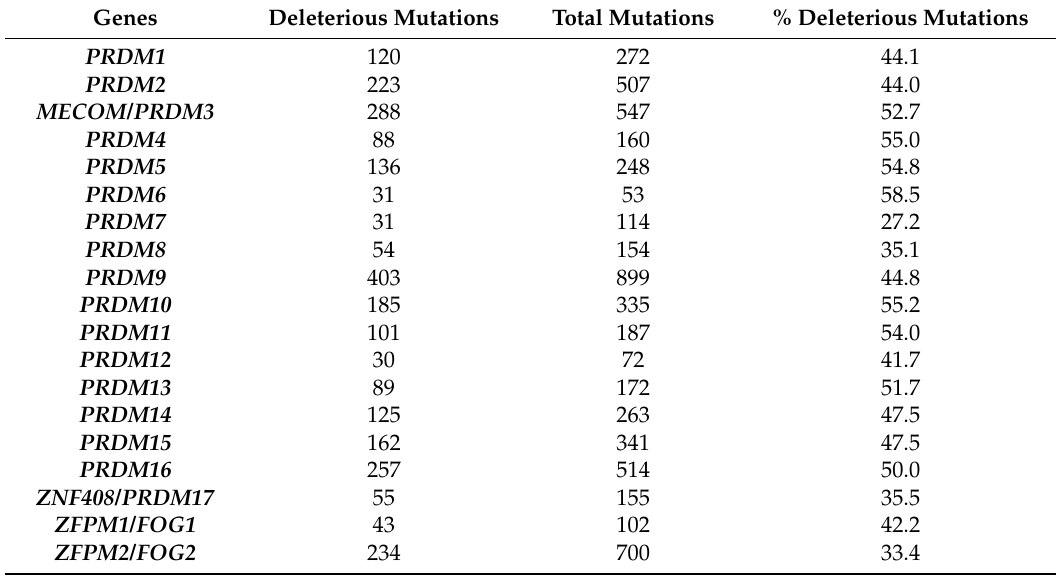
Table 2. Percentage of deleterious and tolerated mutations in the PRDMs across the analyzed tumor samples.